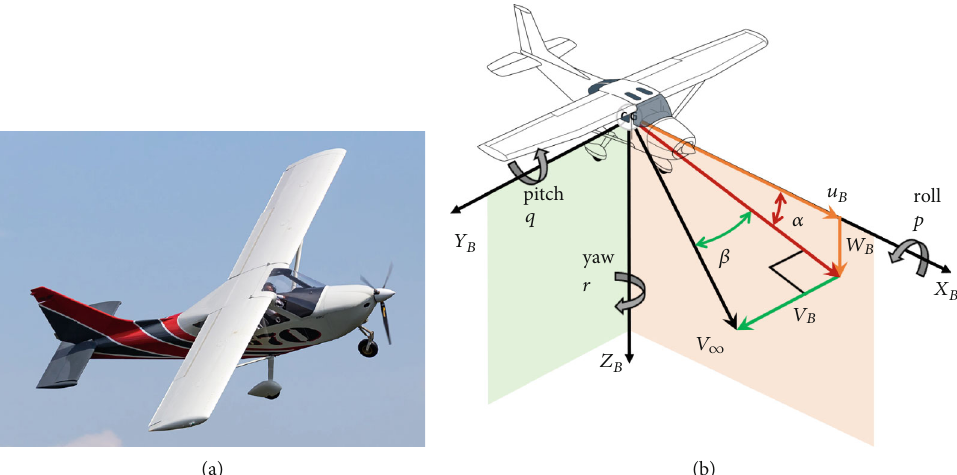
Figure 2: Flight test aircraft (a) G 70 Aircraft from Ing. Nando Groppo S.r.l. and (b) body reference frame with aerodynamic angles ( α , β ), linear relative velocities ( u B , v B , w B ), and angular rates ( p , q , r ). Table 1: Description of training manoeuvres. Flight test no.